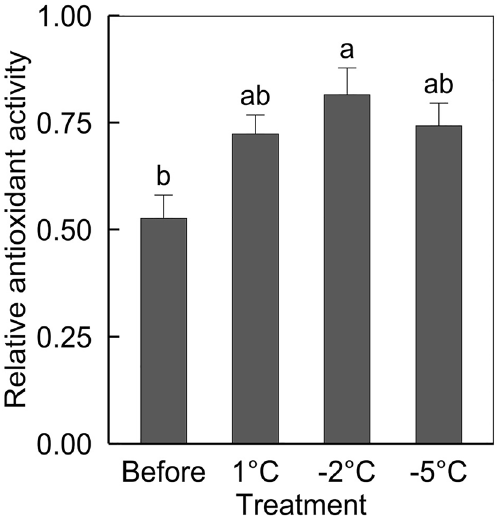
Figure 7. ABTS scavenging activity of three-year-old ‘Hass’ avocado seedling leaves before and after 24-h after exposure to 1, − 2, and − 5 °C for 1 h. Means with standard errors from three replicates with five leaf each. Means with bars followed by different lowercase letters are significantly different according to Tukey’s honestly significant difference test at p <